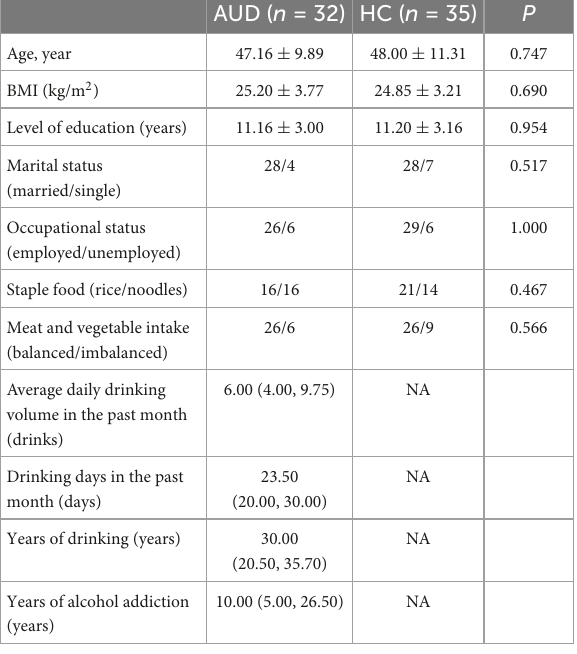
between AUD and HC.